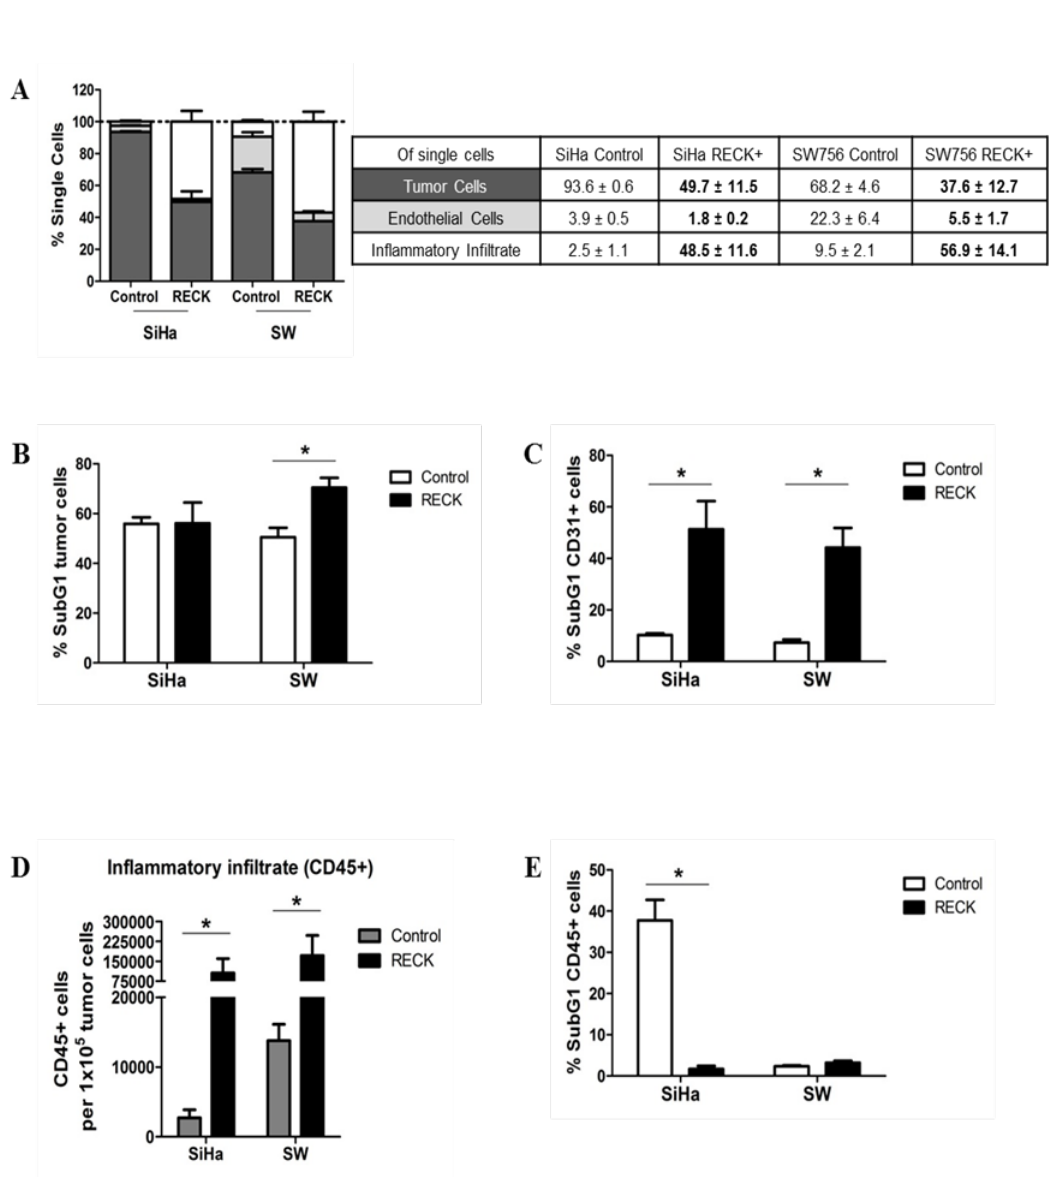
Figure 3. RECK over expression is associated with alterations in tumor microenvironment content. The injection protocol for tumor establishment was the same as described in Figure 1A. Here, the experiment ended once most of the animals from the control group presented tumors with 500 mm 3 . ( A ). Intra-tumoral populations were characterized by immunostaining with anti-CD31 and CD45 antibodies, followed by flow cytometry. Tumor fractions of at least three animals from each group were used for the analysis and at least 1 × 10 5 cells/events were acquired. The EGFP+ population was identified as tumor cells. CD31+ and CD45+ populations identified endothelial cells and inflammatory infiltrate, respectively. Significant differences in population proportion are indicated in bold font in the table. ( B , C , E ) Tumor ( B ), endothelial ( C ) and inflammatory ( E ) cell populations stained with DAPI were evaluated on hypodiploid DNA content (SubG1) using flow cytometry. ( D ) Local inflammatory infiltrate population relative to 100,000 tumor cells. * p < 0.05 by Kruskal–Wallis (3A) or Mann–Whitney (3B–E)